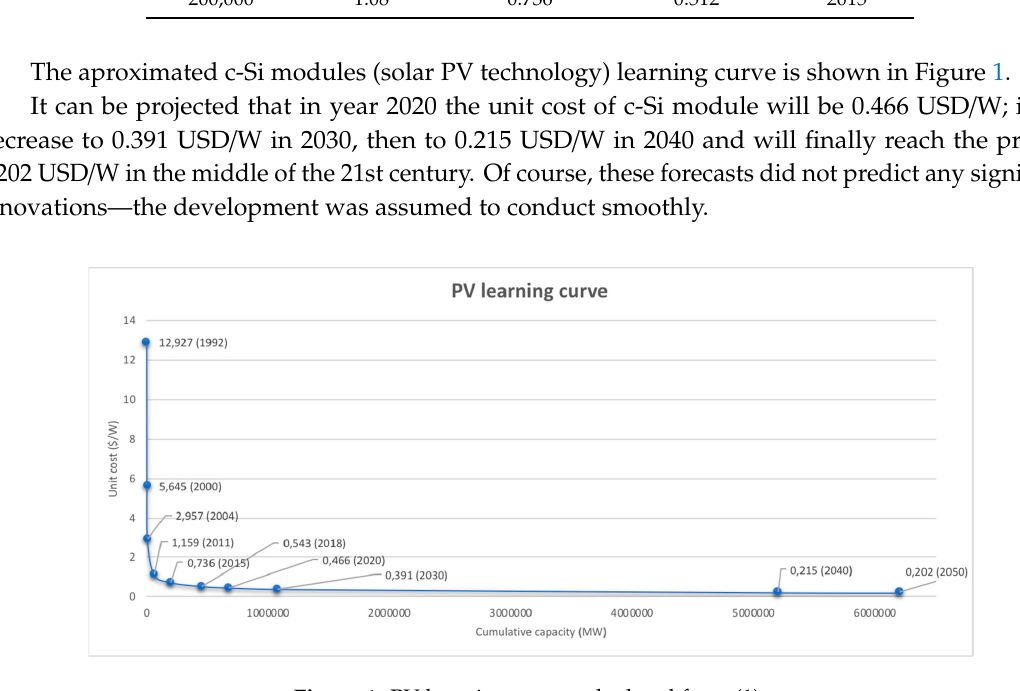
Table 3. Comparison of historical and calculated data for PV. Own work based on [54,55].